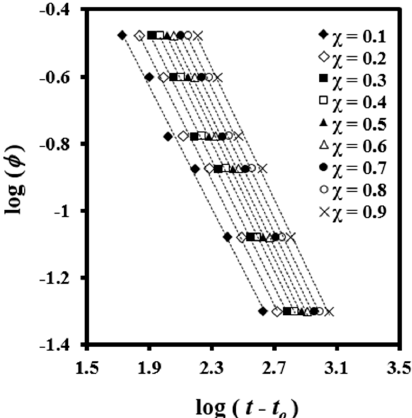
Figure 4. Plots of log φ versus log ( t − t 0 ) for non-isothermal crystallization of PDO performed at the indicated crystallinities.